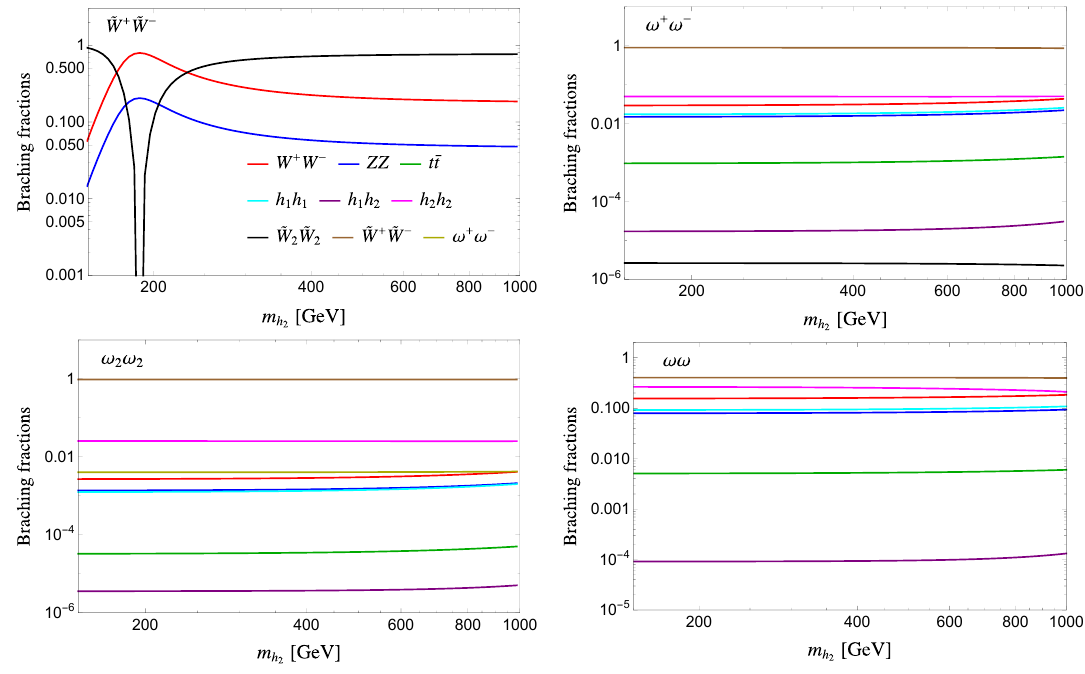
Figure 6. Annihilation branching fractions of vector DM pair ˜ W + ˜ W − (upper left), scalar DM pair ω + ω − (upper right), ω 2 ω 2 (lower left), and ωω (lower right). The other parameters are fixed as BM1 in table